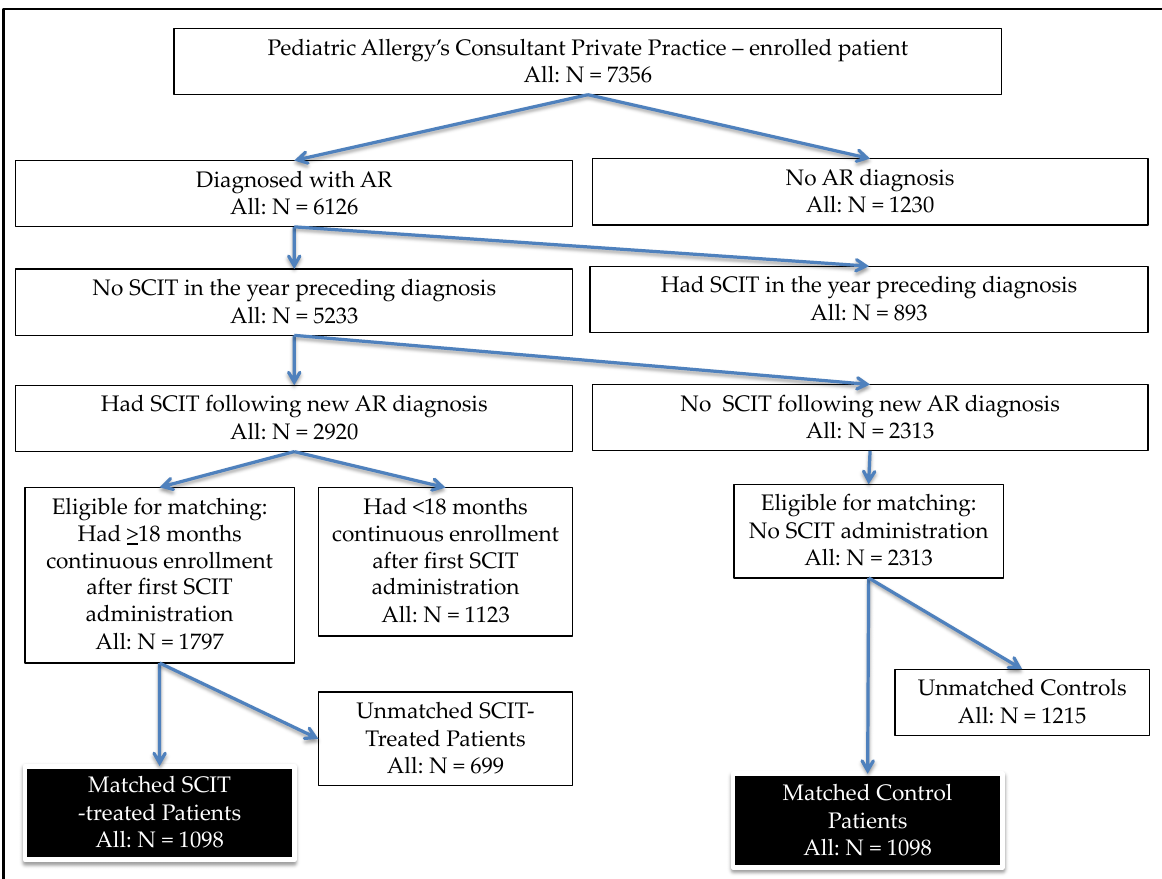
Figure 1. Identification of matched samples. Figure 1. The identification of matched samples. Note: The 8 matching variables were: age, sex, body weight, body height, family history of allergy, symptoms, and medication scores at the SCIT initiation and comorbid atopic conditions (asthma, conjunctivitis, and atopic dermatitis) during the year prior to the SCIT